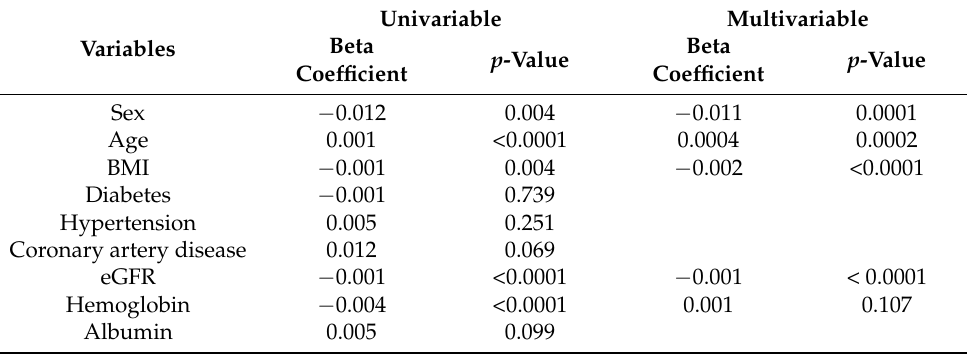
Table 3. Linear regression analysis on the determinants of surface-area-to-volume